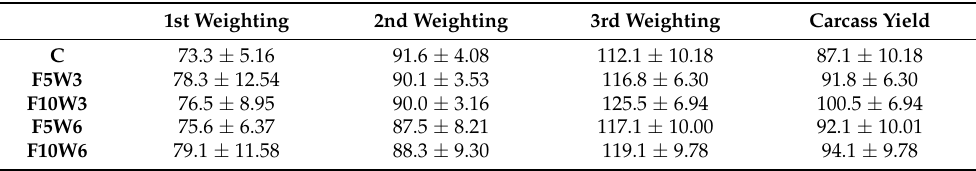
Table 1. Weight values of pigs during fattening period and after slaughter expressed as carcass yield (means ± SD) expressed as kg − 1 .